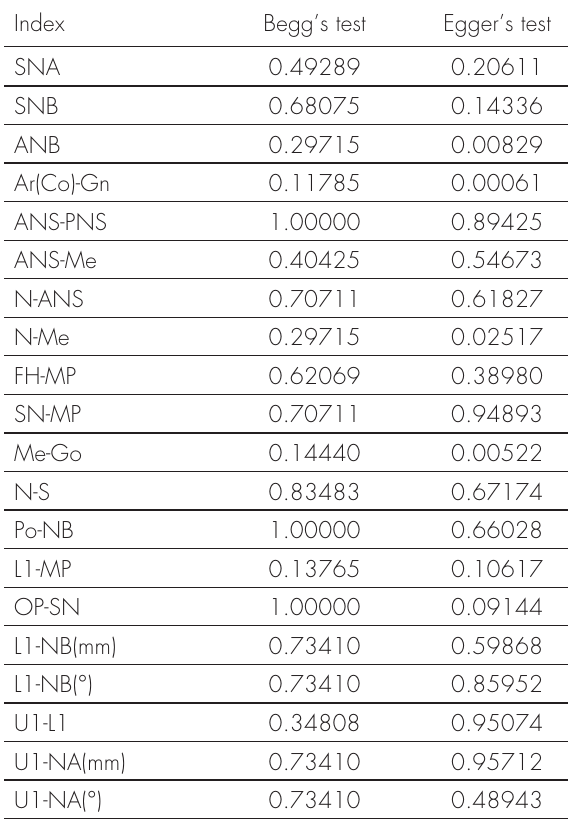
Table VII. Results of publication